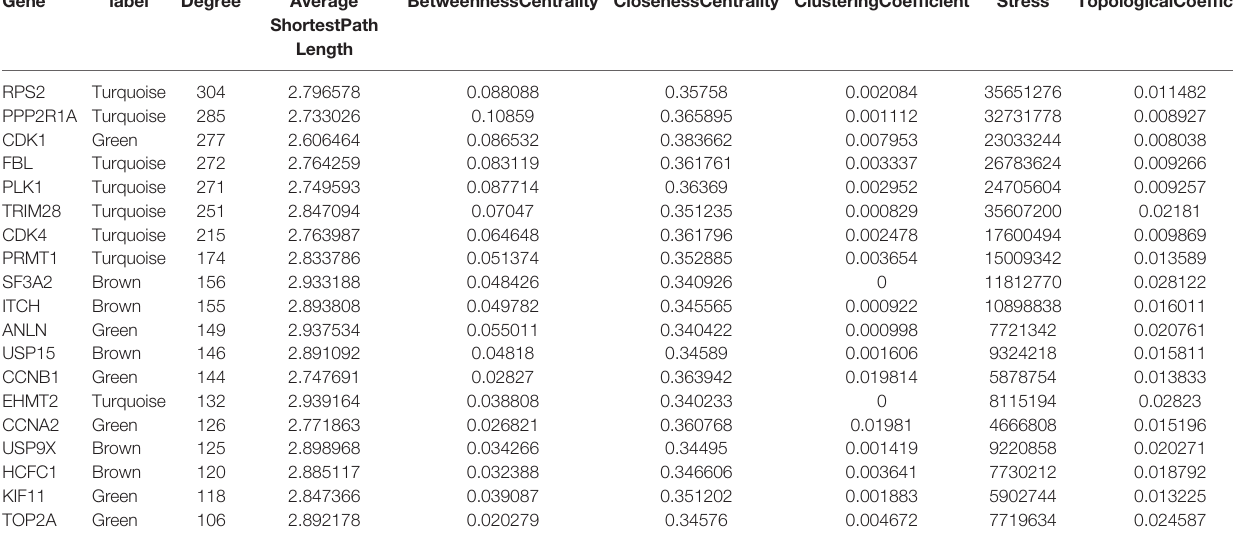
TABLE 2 | Network topological characteristic of top 20 nodes in PPI